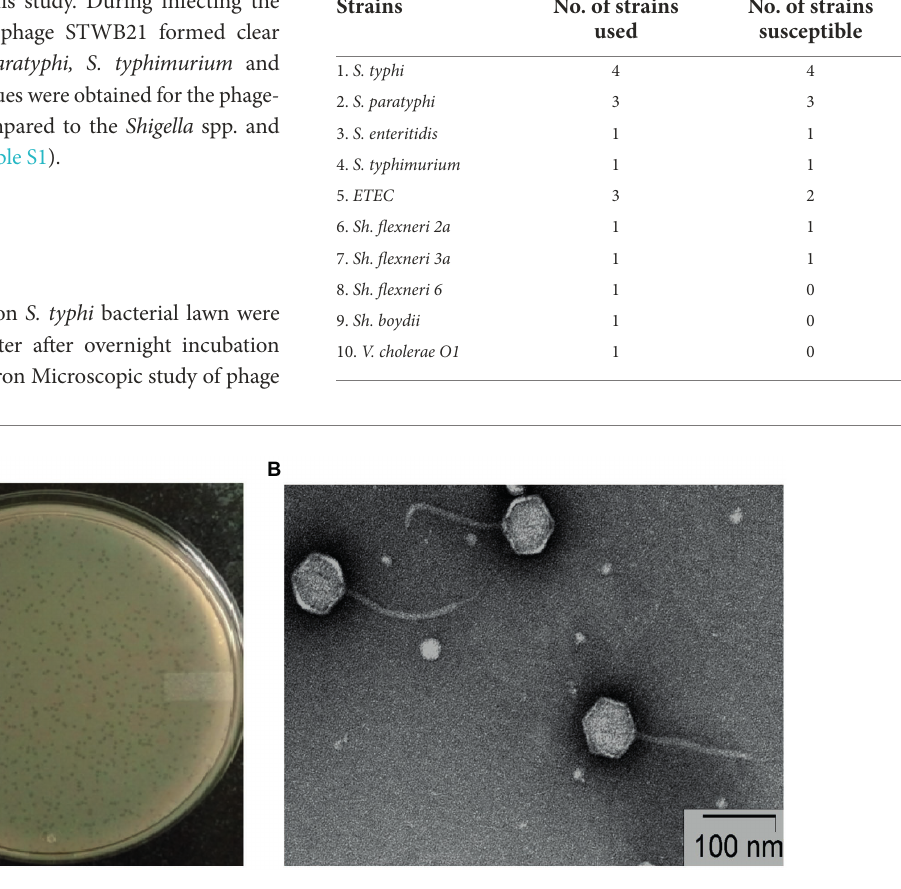
FIGURE 1 Morphology of bacteriophage STWB21. (A) Plaque morphology of phage STWB21, (B) transmission electron microscopic morphological study of phage